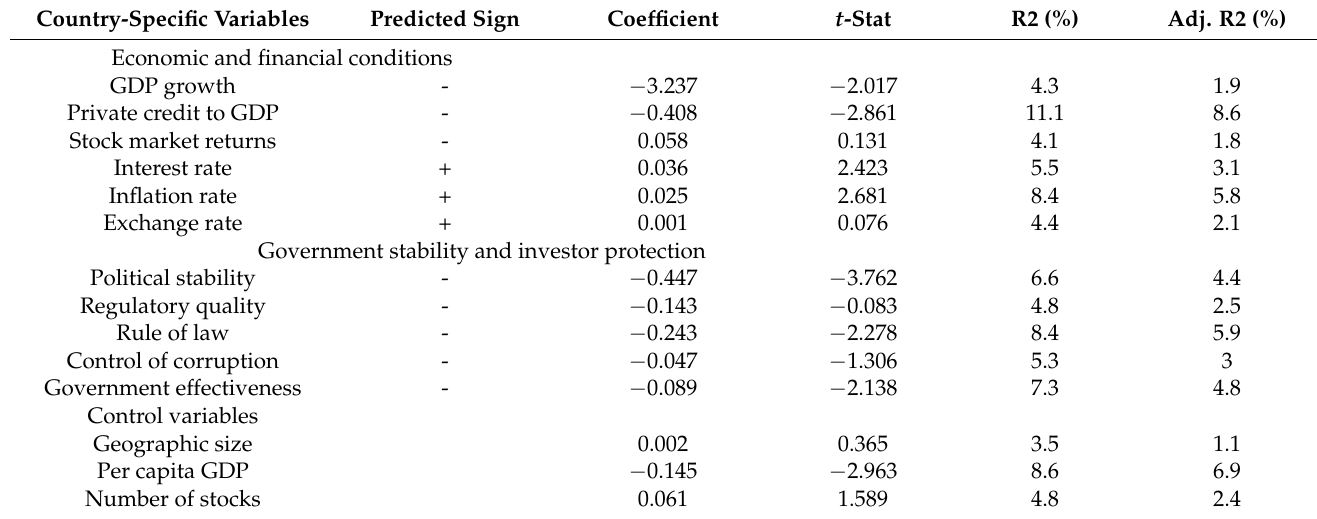
Table 4. Cross-country regression for individual country-level determinants of liquidity